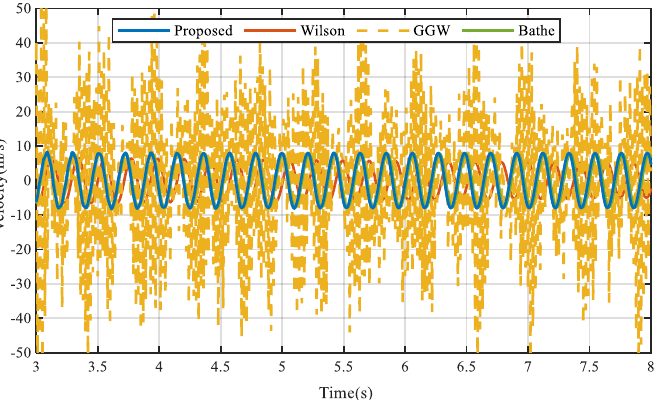
Figure 15. Acceleration responses of Point A with the Wilson method, Bathe method, GGW method, trapezoidal rule and the proposed method: ( a ) responses from 0 to 10 s; ( b ) partial enlarged drawing of responses from 9 to 10 s.